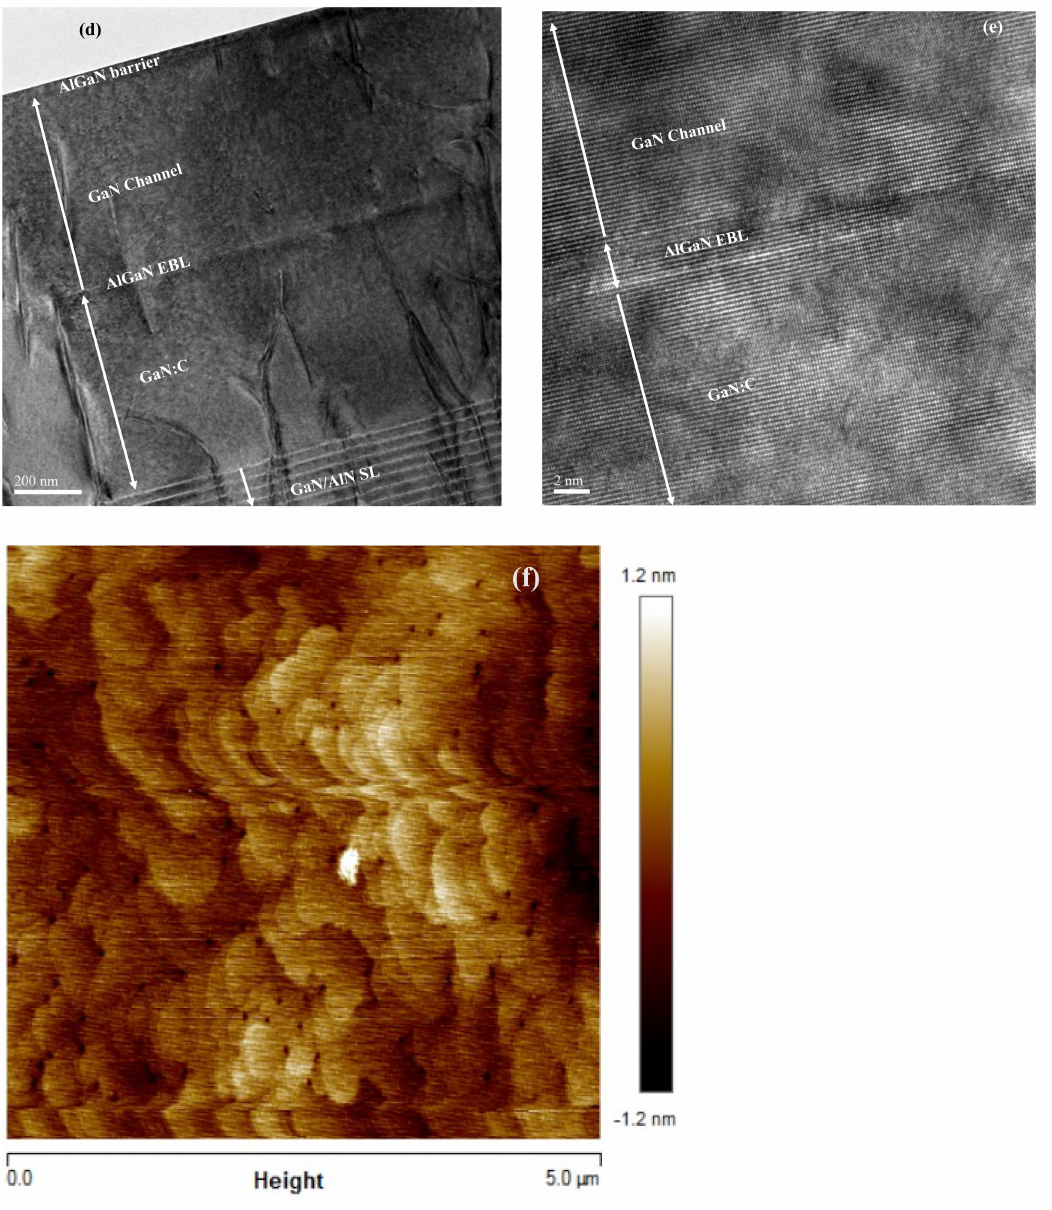
Figure 1. ( a ) The device structure of the GaN:C buffer AlGaN/GaN HEMT with AlGaN EBL; ( b ) the device structure of the AlGaN/GaN/AlGaN DHFET; ( c ) cross-section of the TEM image of the AlGaN/GaN HEMT with GaN:C buffer with AlGaN EB; ( d ) the TEM image of the GaN channel/AlGaN EBL/GaN:C, ( e ) The TEM image of the AlGaN EBL; ( f ) surface morphology of the GaN:C buffer AlGaN/GaN HEMT with AlGaN